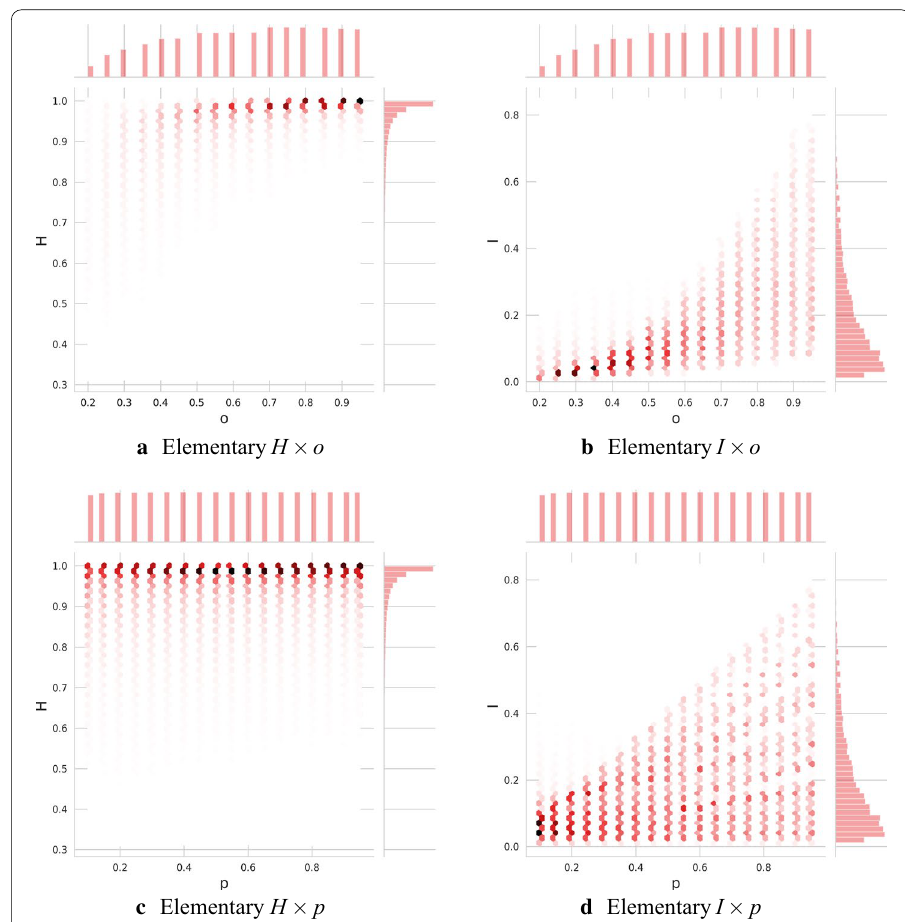
Fig. 9 Results on synthetic multiplex networks without considering transition coupling. There is small dependency on the layer assignment probability o to nodes, since the higher it is, the more overlap may occur. The homogeneity ( c ) shows less dependency to the inner-layer edge probability p than intensity ( d ), which also increases the likelihood of layer overlap